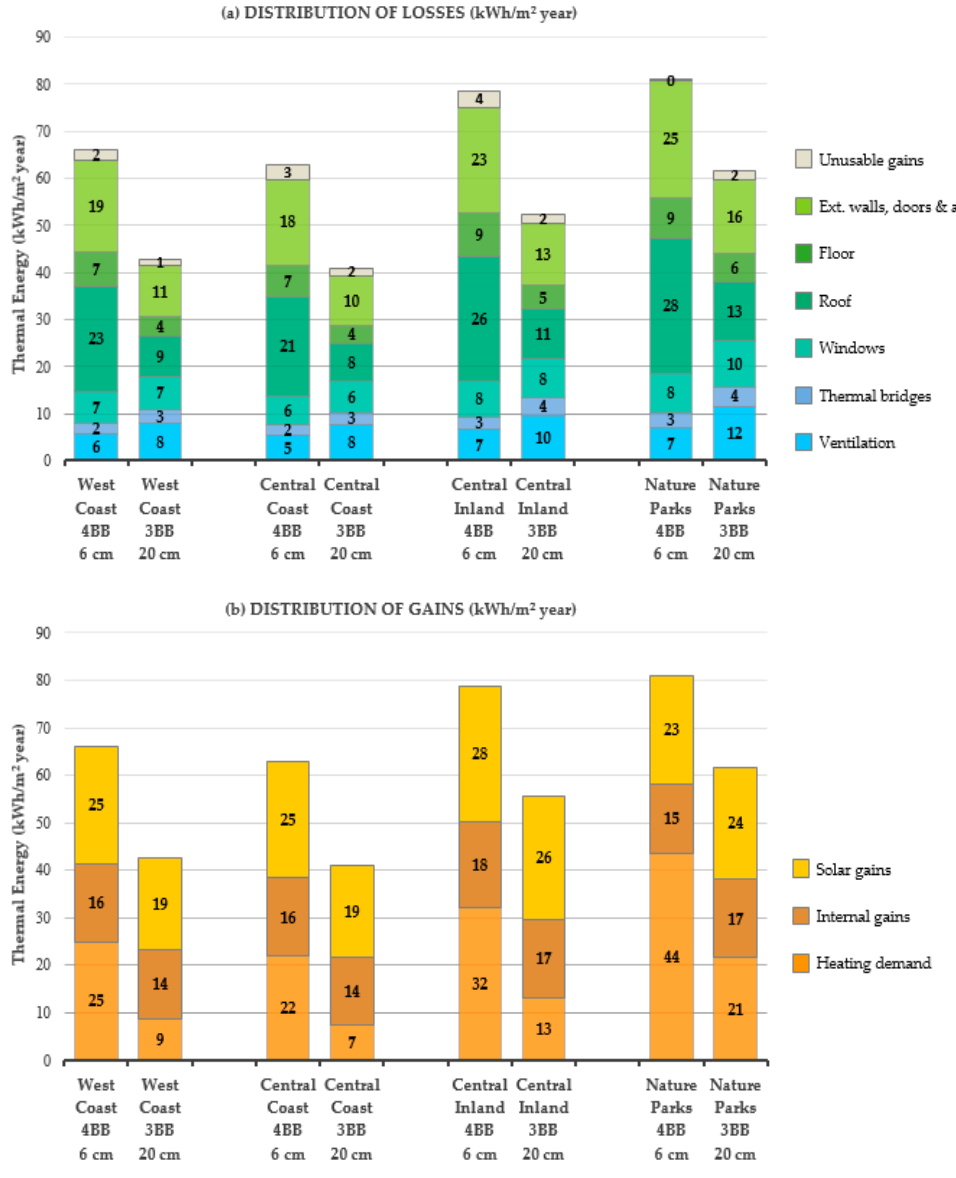
Figure 4. Thermal balances for the four locations with south–north orientation for 4BB (e XPS = 6 cm) and 3BB (e XPS = 20 cm): ( a ) Losses; ( b ) Gains.